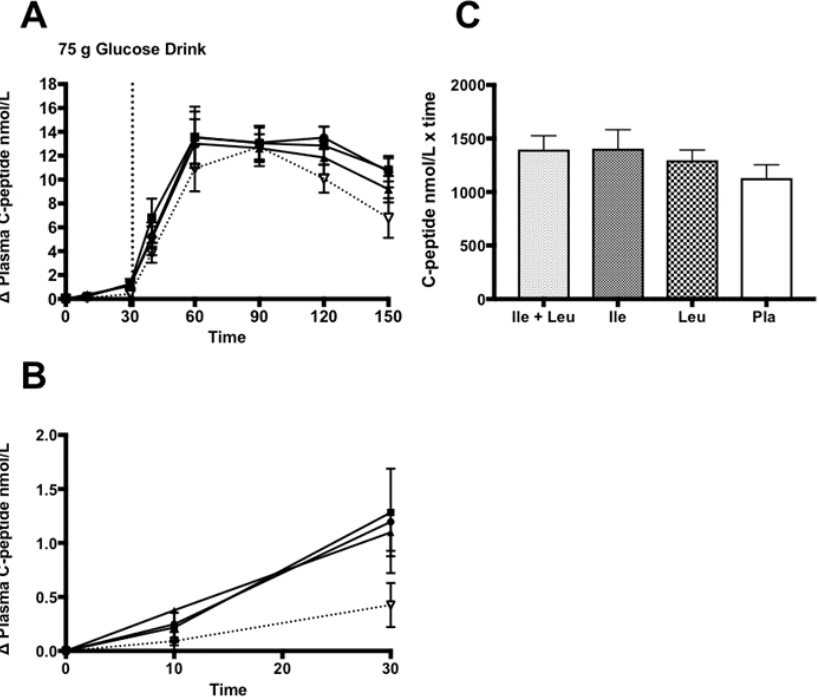
Figure 4. Plasma C-peptide (nmol/L) (mean ± SEM) comparing Ile + Leu, Ile, Leu, and Pla. ( A ; 0 – 150 min) main effect treatment ( p = 0.04); Ile vs. Pla ( p = 0.04). ( B ; 0 – 30 min) no main effect of treatment found. ( C ; iAUC) No differences were found ( p = 0.11).